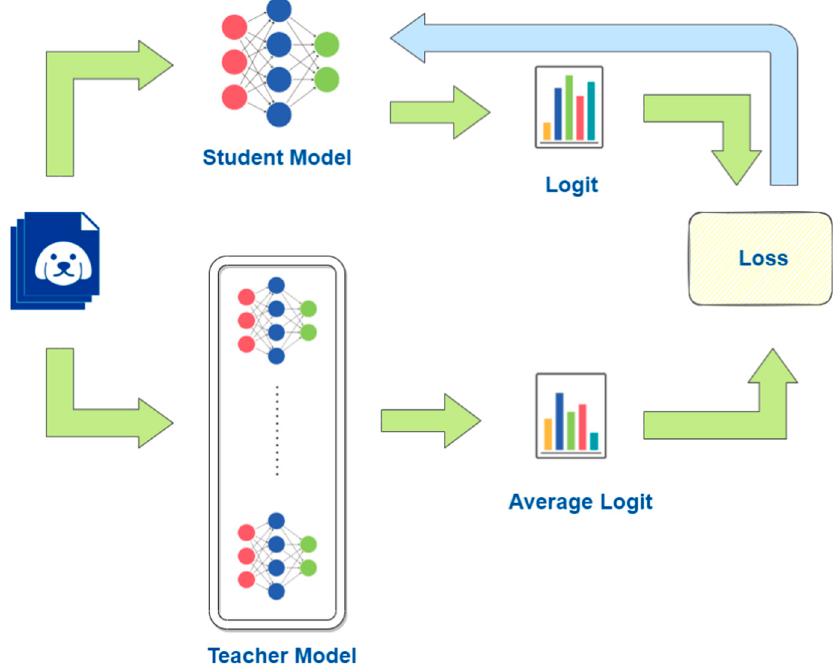
Figure 1. The schematic diagram and information flow of FedDF [19] (The green-color arrows indicates the forward training direction and the blue arrow the backward training one).